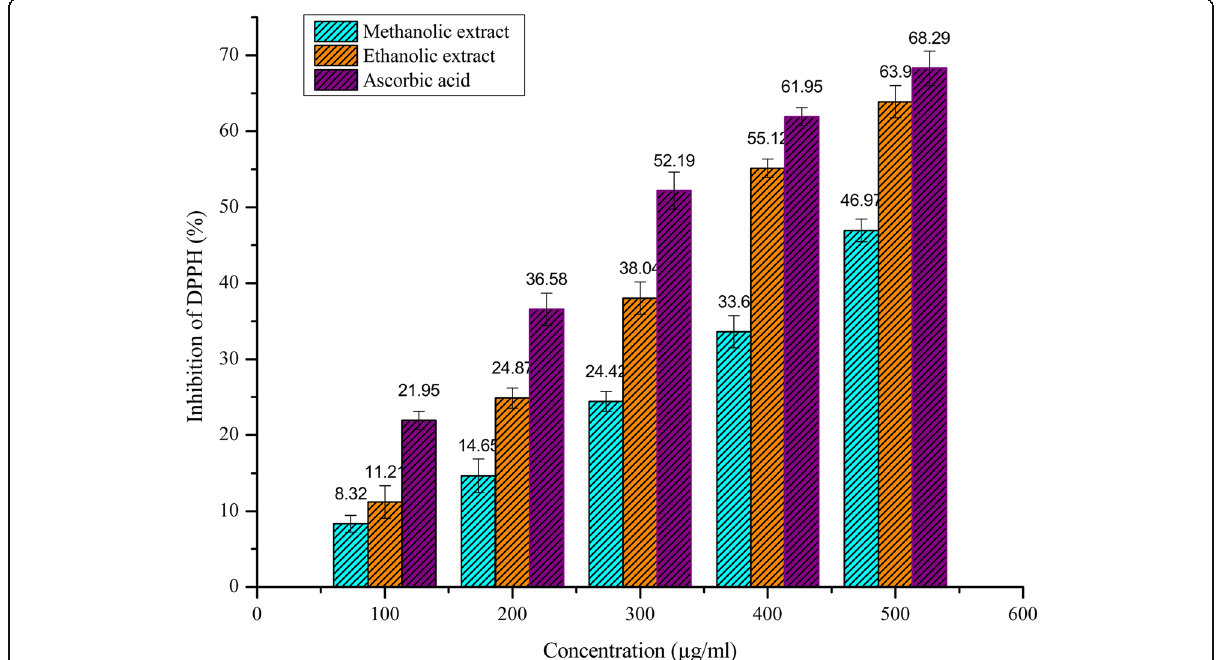
Fig. 4 Inhibition of DPPH by methanolic and ethanolic extracts of C. zeylanica leaves. The results were expressed as mean ± standard deviation